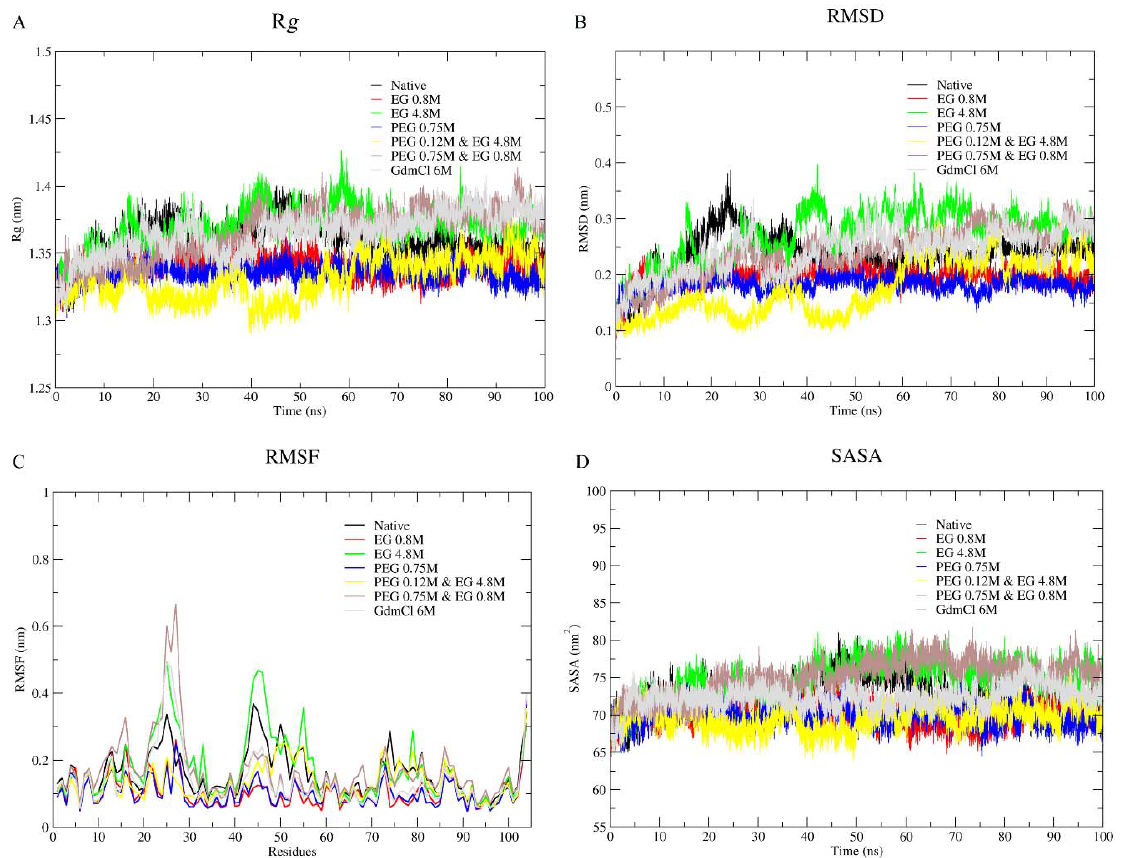
Figure 3. Line plots showing R g values ( A ) , RMSD of C α atoms ( B ), RMSF ( C ), and SASA ( D ) of cyt c in water and in various solutions. Table 2. Average values of R g , RMSD, RMSF, and SASA obtained from MD simulations of cyt c in different solvent conditions.